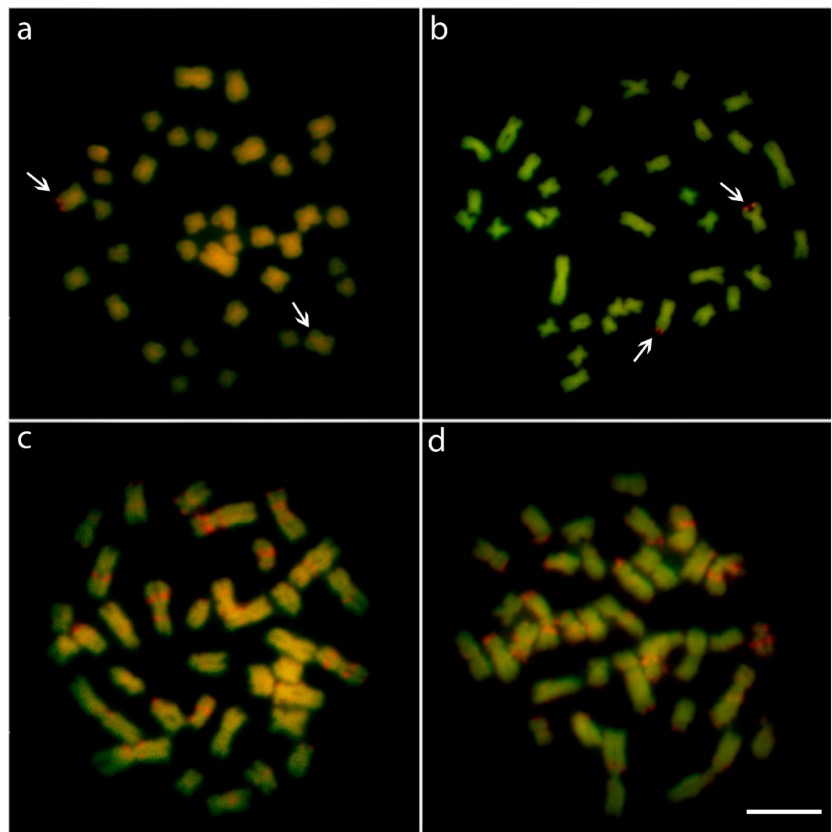
Figure 2. Metaphase plates of male ( a ) and female ( b ) Lebiasina bimaculata and male ( c ) and female ( d ) Lebiasina melanoguttata after DAPI-CMA 3 staining. The arrows indicate the unique CMA 3 + site and its polymorphic state between male and females of L. bimaculata . In L. melanoguttata , males and females display a set of CMA 3 + (GC-rich) and DAPI + (AT-rich) regions on the chromosomes. Scale bar = 5 µ m.